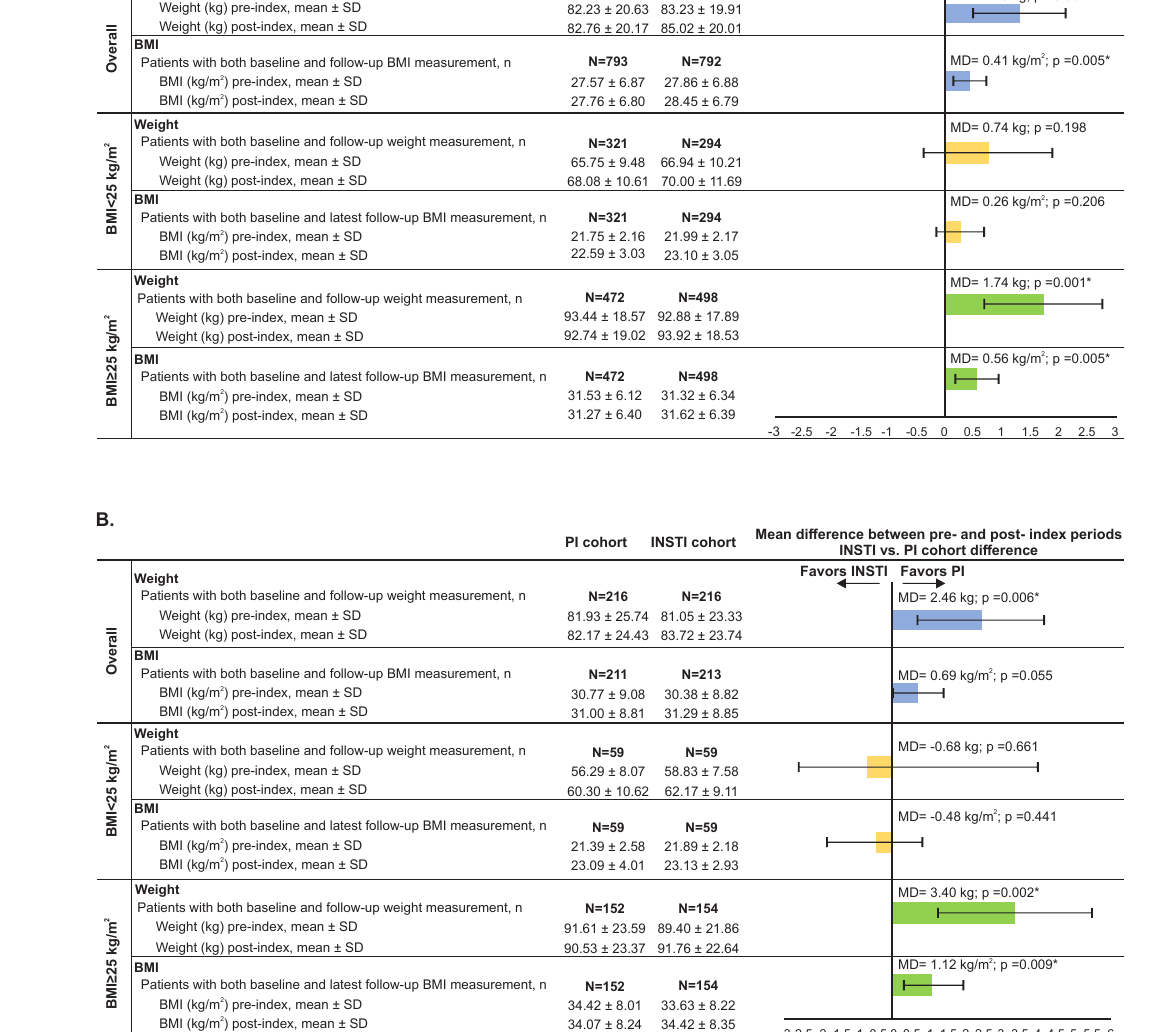
Figure 2. Mean Change in Weight and BMI, Overall and by Baseline BMI W eight Patients with both baseline and follow-up weight measurement, n Weight (kg) pre-index, mean ± SD